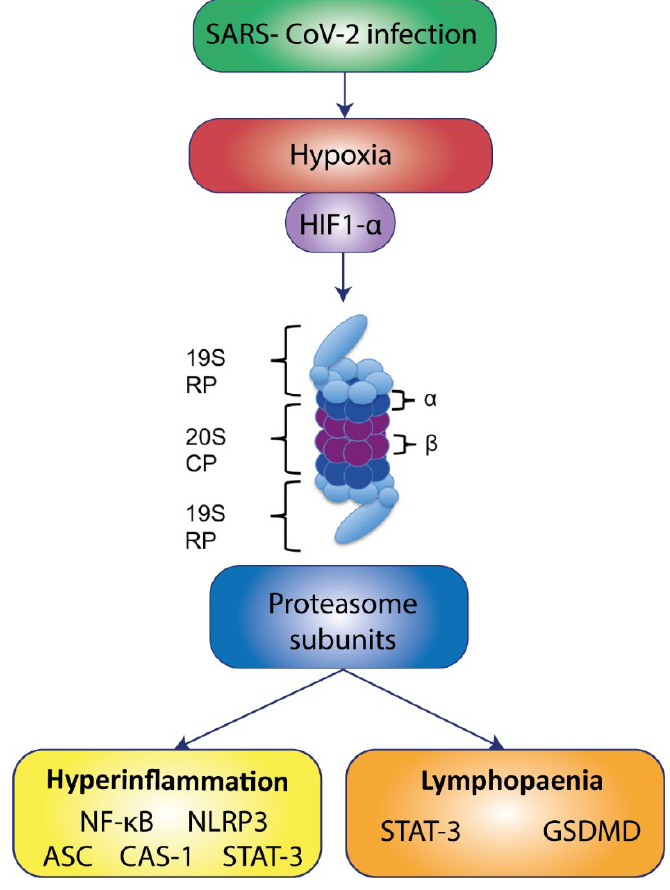
Figure 6. Proteasome might play an important role in COVID-19 pathogenesis. SARS-CoV-2 infection induces hypoxia which, we suggested, leads to overexpression of proteasome subunits in PBMCs from patients with COVID-19, potentially leading to an overactivation of the ubiquitin-proteasome system. The pleiotropic roles of proteasome in immune biology include regulation of master proteins such as, NF- κB, NLRP3, GSDMD and STAT3, which have been related to COVID-19 complications, mainly lymphopenia and hyperinflammation.